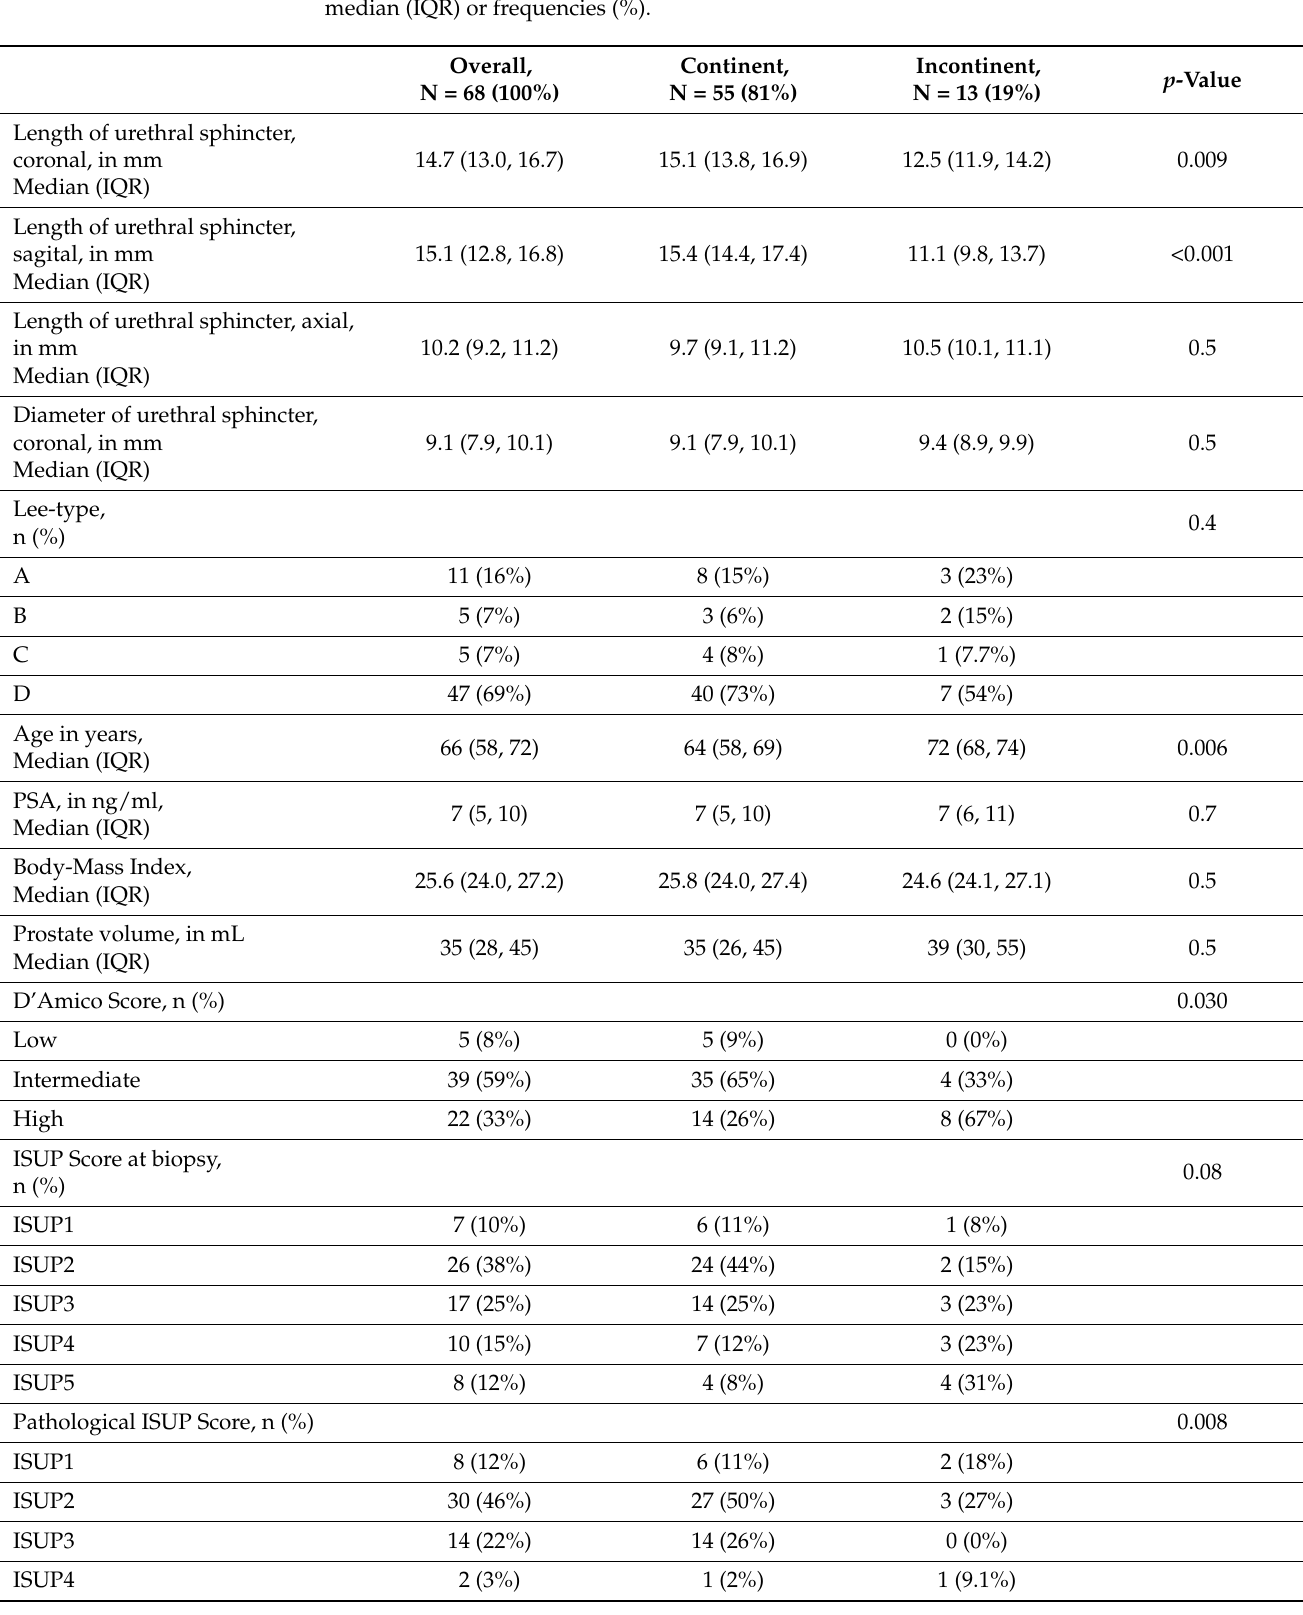
Table 2. Patient and clinicopathological characteristics of 86 radical prostatectomy patients between 03/2018 and 12/2019, stratified according to mid-term urinary continence status; all values are median (IQR) or frequencies